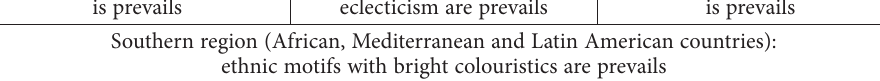
Table 1. Ethnic motives in the advertising poster (source: created by author) Northern region (Scandinavian countries): ethnic motifs with limited colours range are prevails Western Europe and North America: international